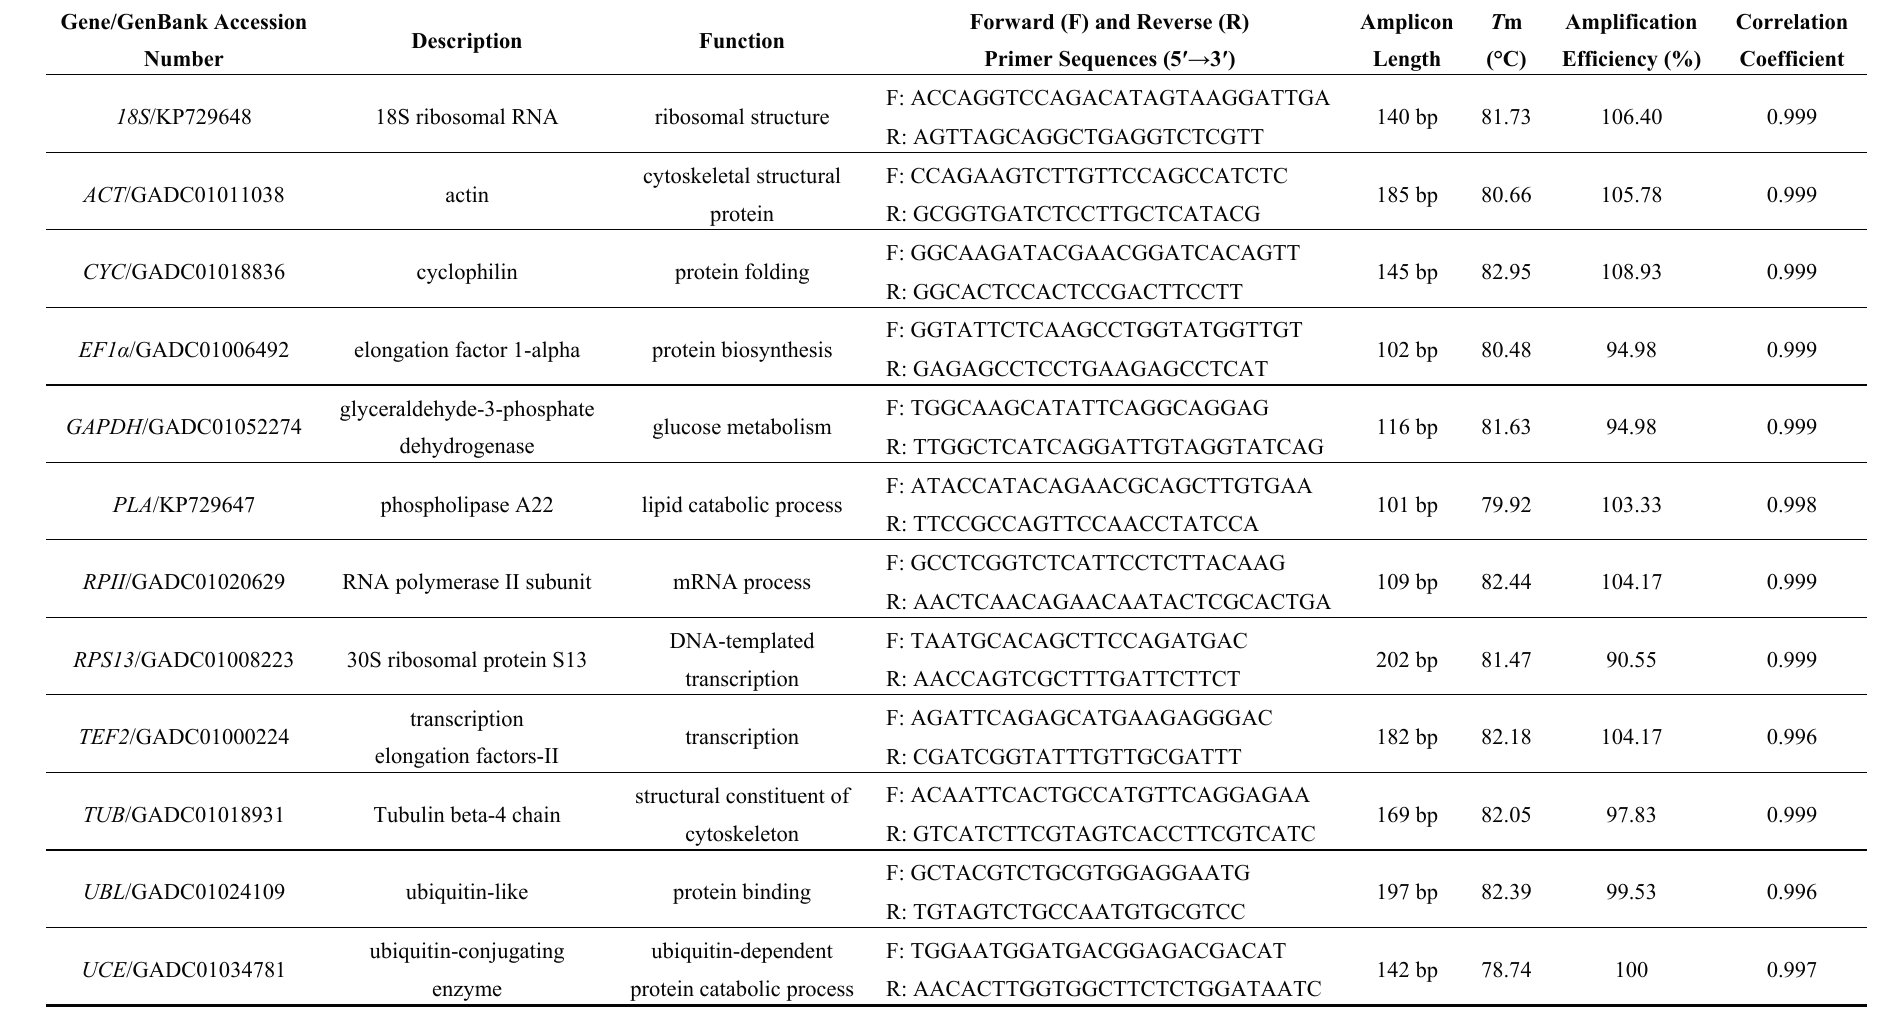
Table 1. Selected candidate reference genes, primer sequences and PCR amplification